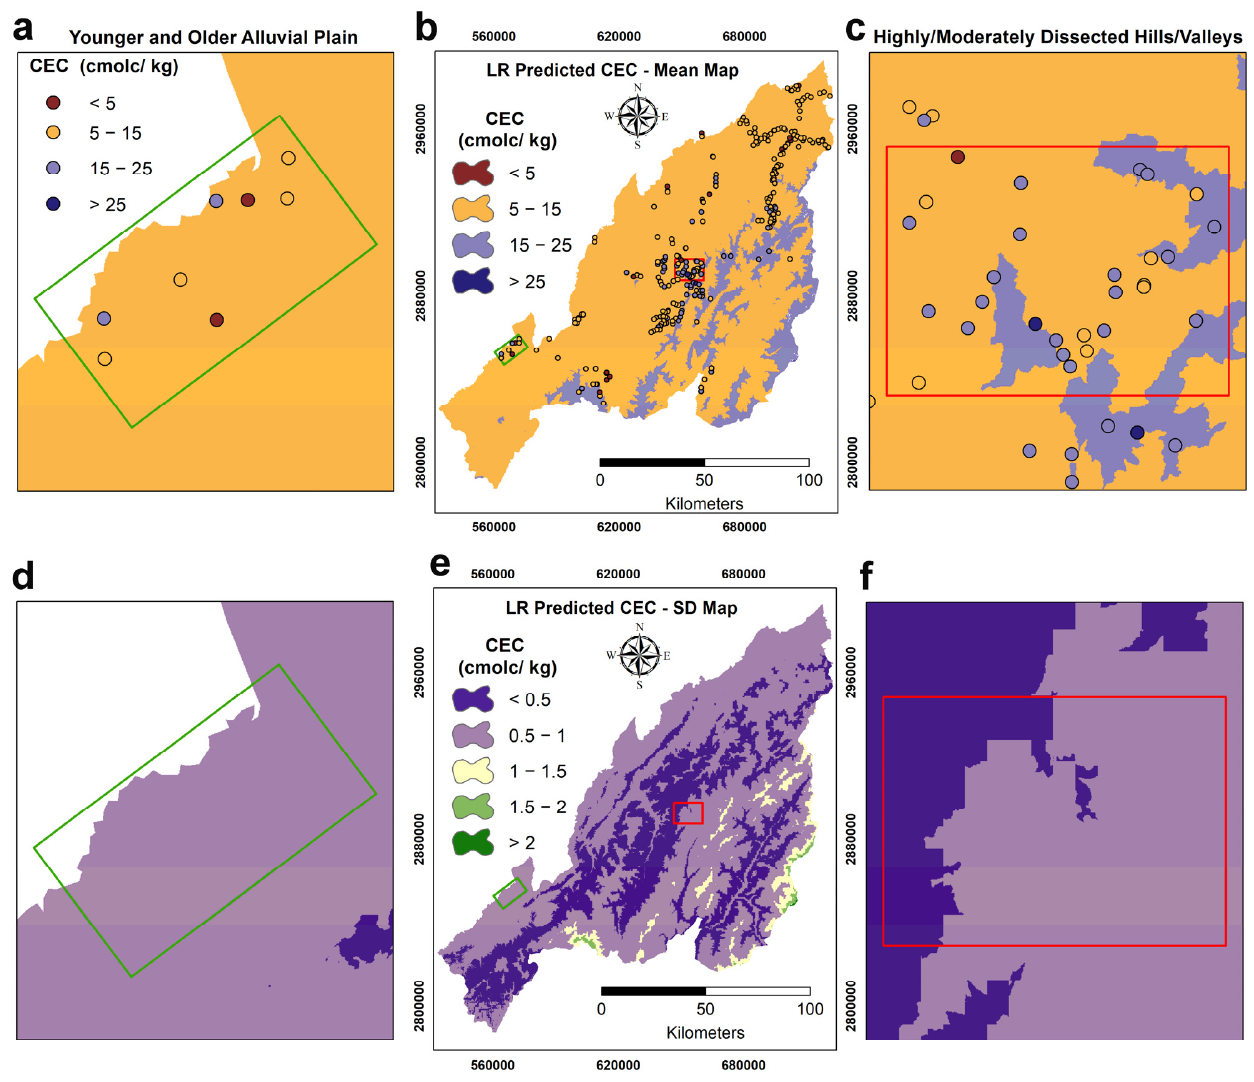
Figure 7. Digital maps of CEC (0–30 cm) were generated by applying a Lasso Regression (LR) model: Zoomed to a young and older alluvial plain area as mean CEC map ( a ) and as uncertainty CEC map ( d ); mean CEC map over Nagaland ( b ) resulting from the prediction among 10 iterations; zoomed to a highly/moderately dissected hills and valleys as mean CEC map ( c ) and as uncertainty CEC map ( f ); uncertainty CEC map over Nagaland ( e ) resulting from the standard deviation of 10 iterations.